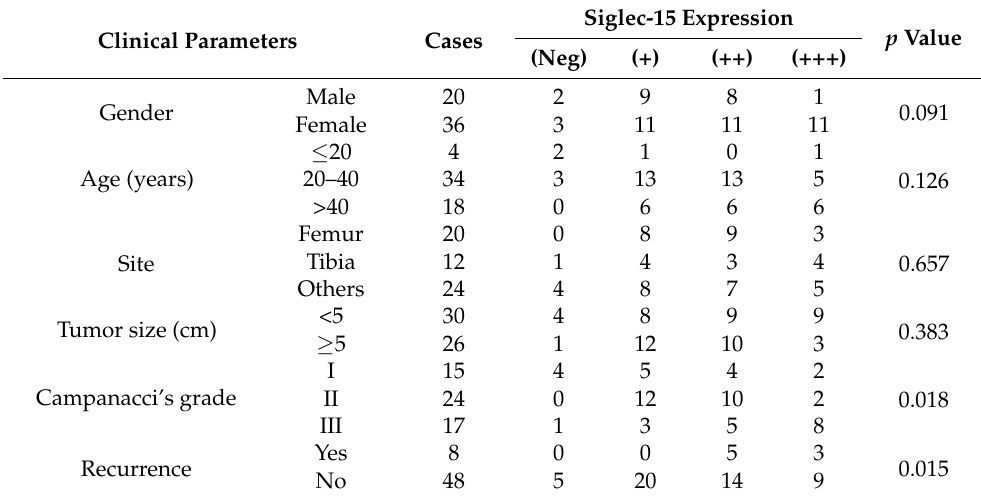
Table 1. Difference between Siglec-15 expression on GCTB tissues and Clinical parameters. Clinical Parameters